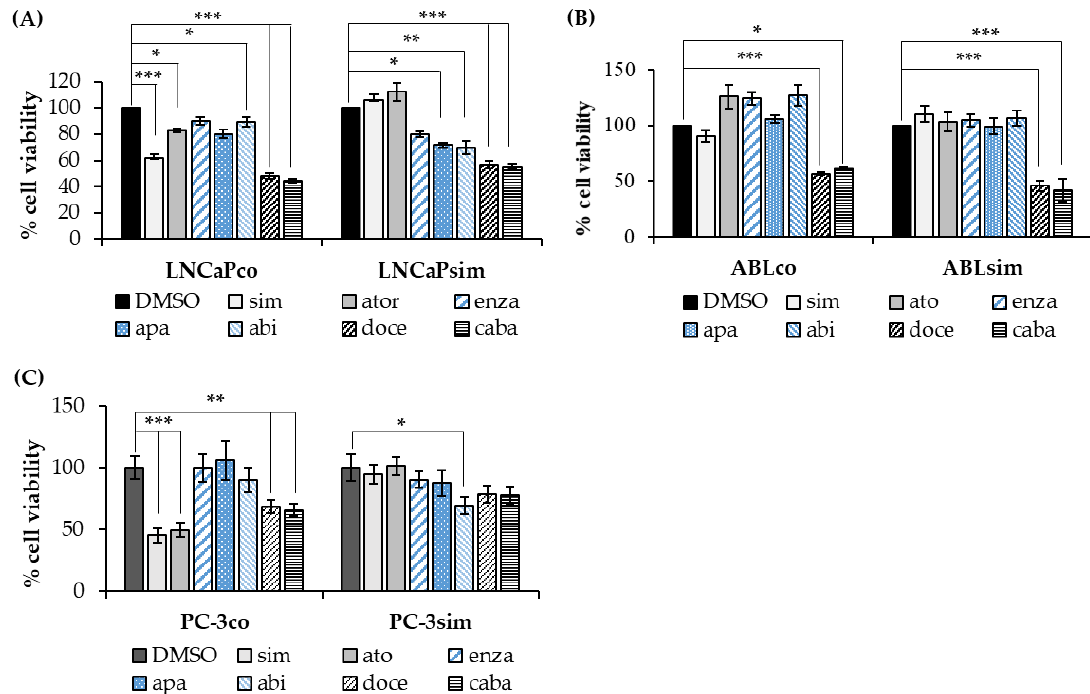
Figure 4. Effects of statins, antiandrogens and chemotherapeutics on long-term simvastatin-treated cell lines. LNCaP ( A ), ABL ( B ), and PC-3 ( C ) cells were treated with 5 µM simvastatin (sim), 5 µM atorvastatin (ato), 5 µM enzalutamide (enza), 5 µM apalutamide (apa), 5 µM abiraterone acetate (abi), 12 nM docetaxel (doce) and 12 nM cabazitaxel (caba) over 72 h and viability was measured with a colorimetric cell viability assay. Cell viability was expressed as percentage of mock control. Data are represented as mean ± SEM. (* p < 0.05, ** p < 0.01, *** p < 0.001).